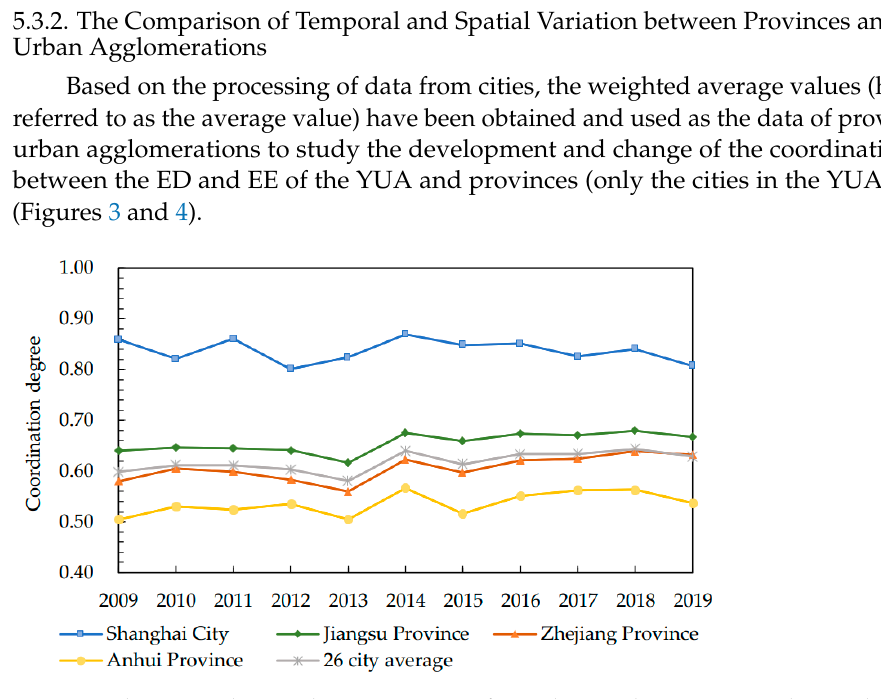
Figure 3. Changes in the Development Degree of Coordination between ED and EE in the YUA from 2009 to 2019.